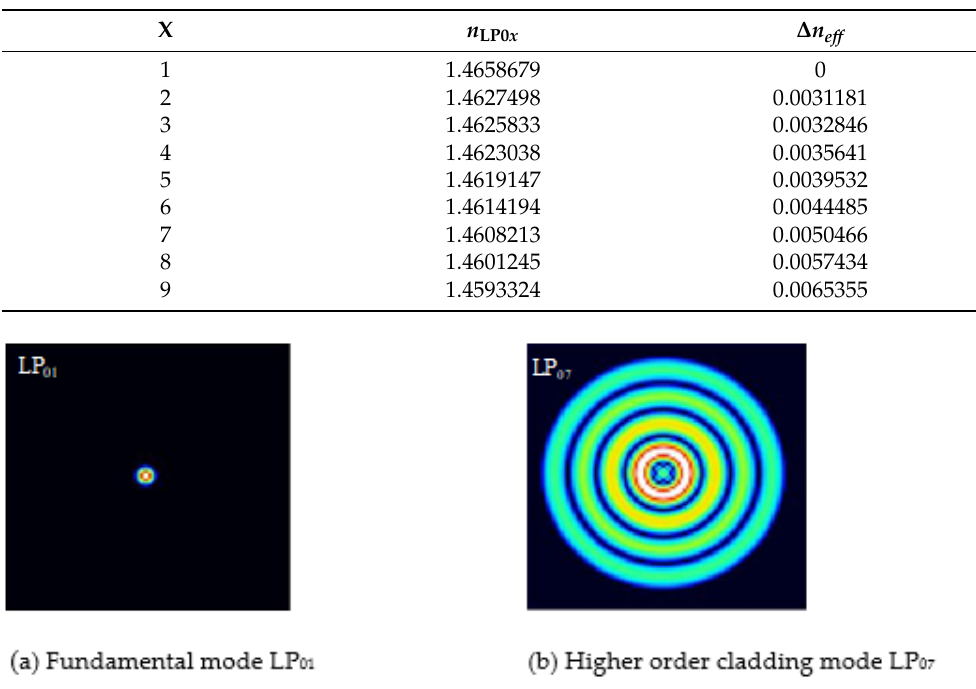
Figure 6. Optical mode distribution diagram of optical fiber section.